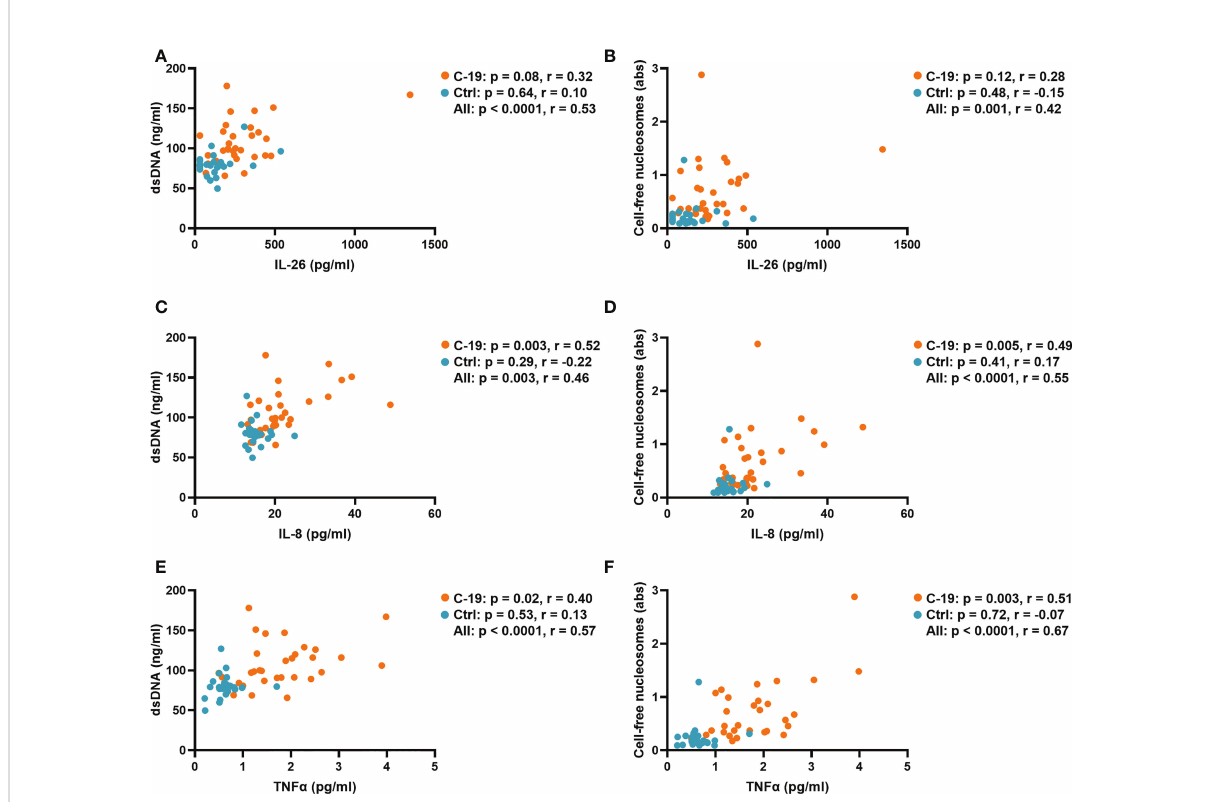
FIGURE 3 The plasma concentrations of IL-8 and TNF a are associated with those of NET markers in COVID-19 patients. Spearman correlation analyses of the plasma concentrations of IL-26, IL-8 and TNF a with the plasma concentration of (A, C, E) double-stranded DNA (dsDNA) and the plasma levels of (B, D, F) cell-free nucleosomes from the COVID-19 (orange) and Control (blue)